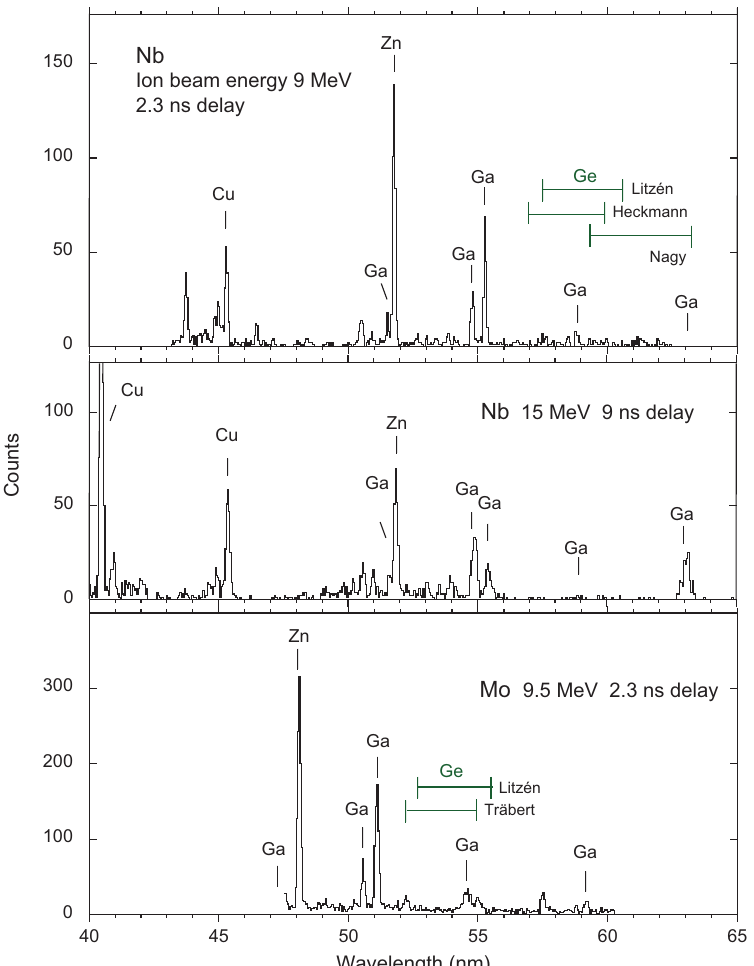
Figure 1. Delayed beam-foil spectra of Nb and Mo in the wavelength range of the Zn-, Ga- and Ge-like ion intercombination lines. Prominent lines are marked by the isoelectronic sequence; the five Ga-like ion intercombination lines are indicated at positions stated by Biémont et al. [66], the two intercombination lines in Ge-like ions (green markers) at positions claimed by experiment [48,51,67] or theory [68]. The Nb spectrum in the middle panel has been recorded farther away from the exciter foil (at a longer delay after excitation); therefore, wider spectrometer slits were used, which result in a larger line width. Changes in relative line intensity between the spectra relate to differences in upper level lifetime. Such spectra are also affected by the deterioration of the exciter foil under ion beam impact. The limited foil standing time and available machine time force the experimenter to economize by tailoring the measurement program, with the result that not all the lines of interest may be covered in such a spectroscopic